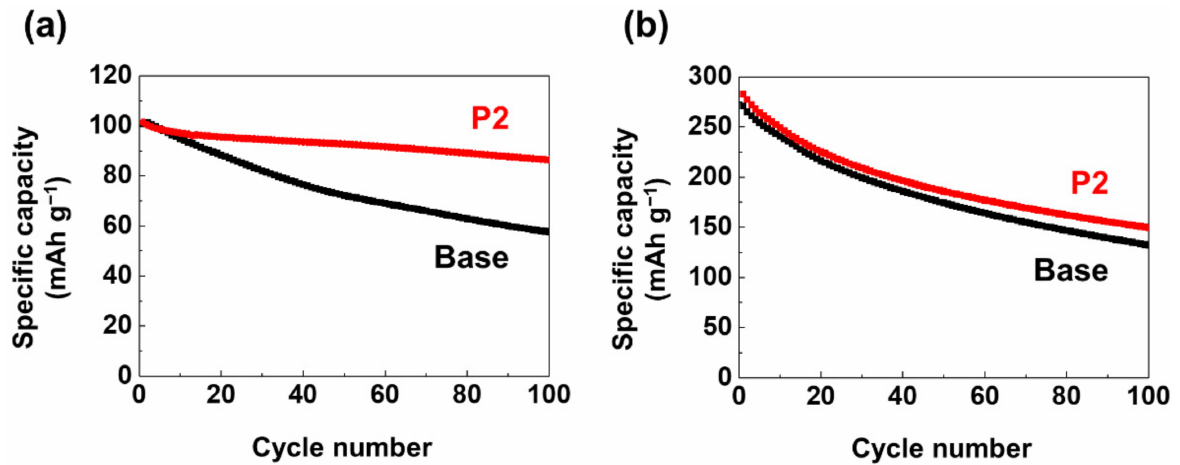
Figure 5. Cycle performance of ( a ) LMO/LMO and ( b ) graphite/graphite symmetric cells at 60 ◦ C. The cells were charged and discharged at 0.5 C over ± 1.3 V for LMO/LMO and ± 0.8 V for graphite/graphite symmetric